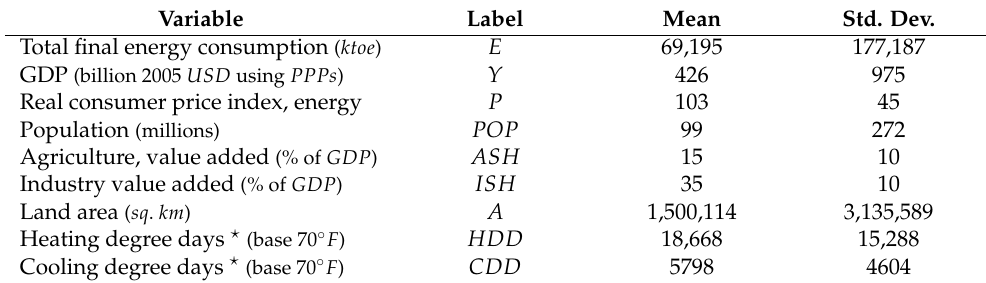
Table 3. Descriptive